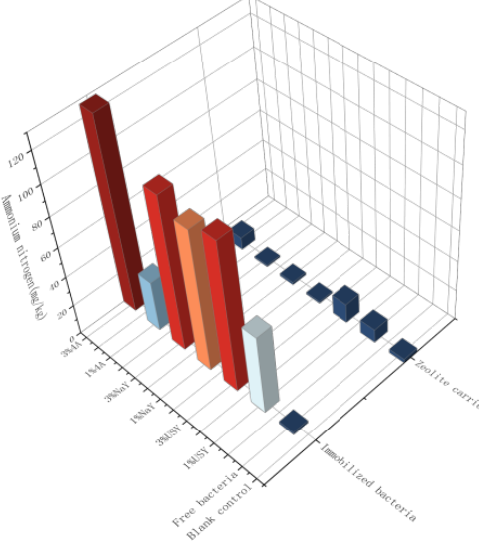
Figure 5. The effect of zeolite and bacteria on soil ammonium nitrogen.